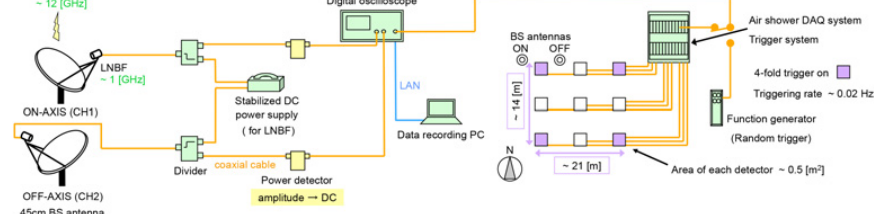
Figure 1. The experimental setup of the microwave antennas with the EAS array at Osaka City University.